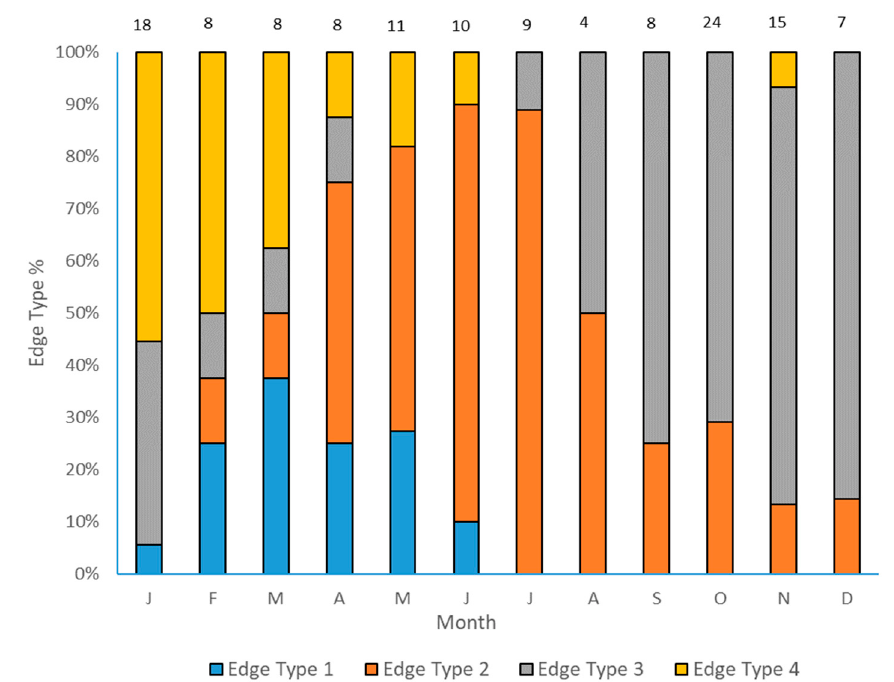
Figure 3. Monthly percentages of all edge types for black margate ( Anisotremus surinamensis ) collected from the Southeastern United States from 1979 to 2017, with total sample sizes above each column. Edge codes: 1 = opaque zone on edge, indicating annulus formation; 2 = small translucent zone, <30% of previous increment; 3 = moderate translucent zone, 30%–60% of previous increment; 4 = wide translucent zone, >60% of previous increment [16].